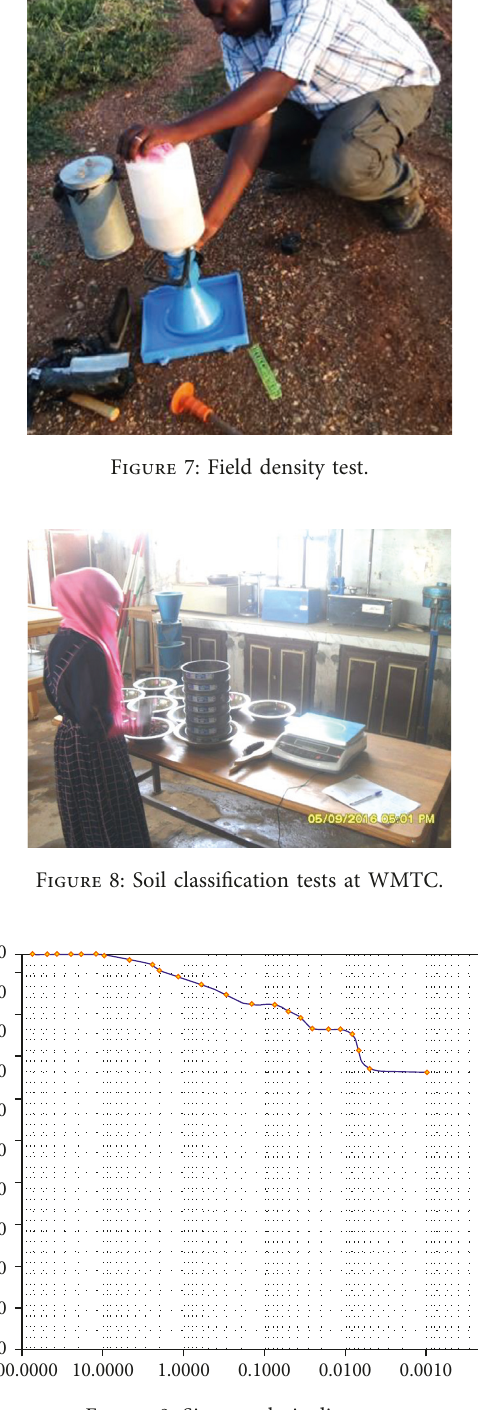
Figure 9: Sieve analysis